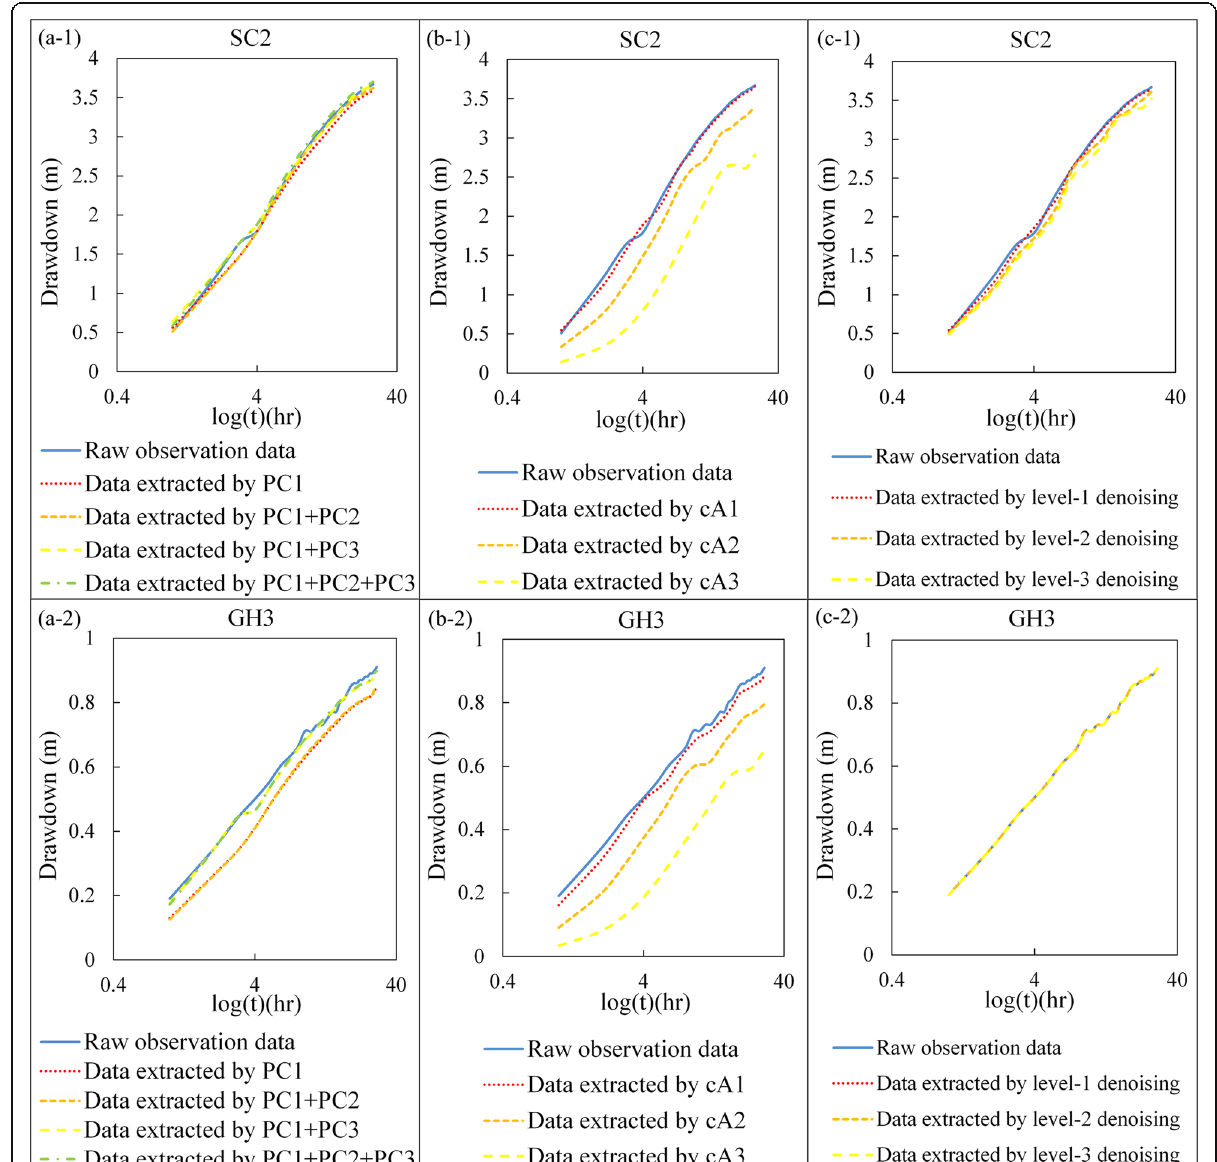
Fig. 13 Comparison of filtered drawdown hydrographs of post-seismic groundwater head by using a SVD, b wavelet transform, and c wavelet de-noising for (-1) SC2 and (-2)